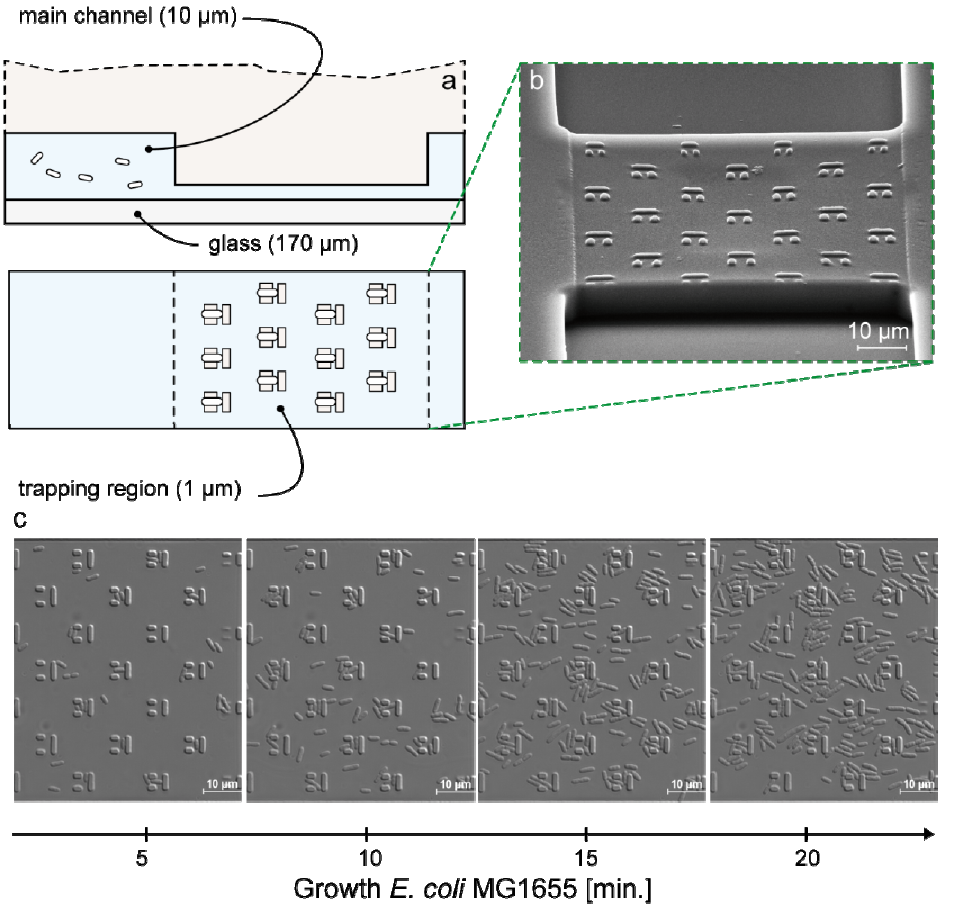
Figure 1. ( a ) Immobilization of single bacteria into a trapping array. ( b ) SEM images of trapping region containing several trapping structures for the immobilization of single bacteria. ( c ) Unspecific adhesion of E. coli leading to crowded growth in first single-cell trapping concept.